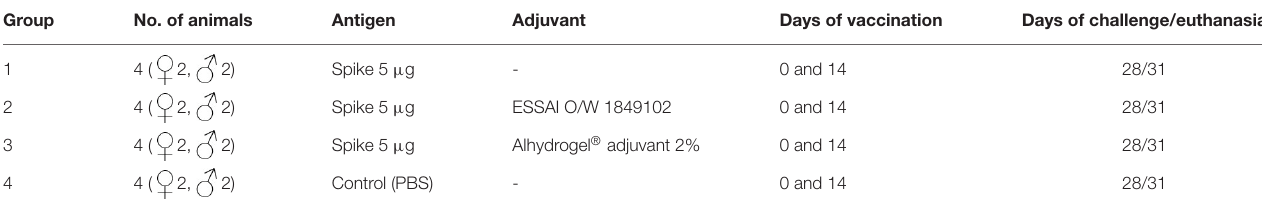
TABLE 1 | Design of the experimental SARS-CoV-2 vaccine study.